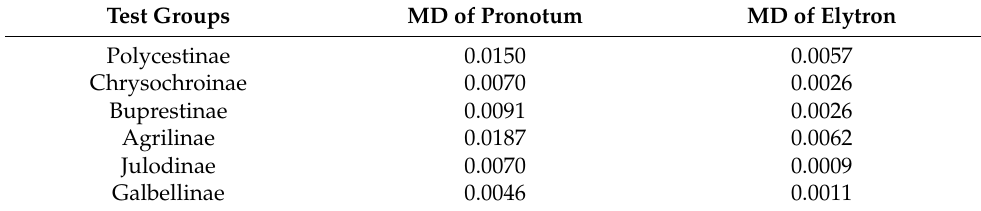
Table 2. Morphological diversity (MD) of test traits of subfamilies.